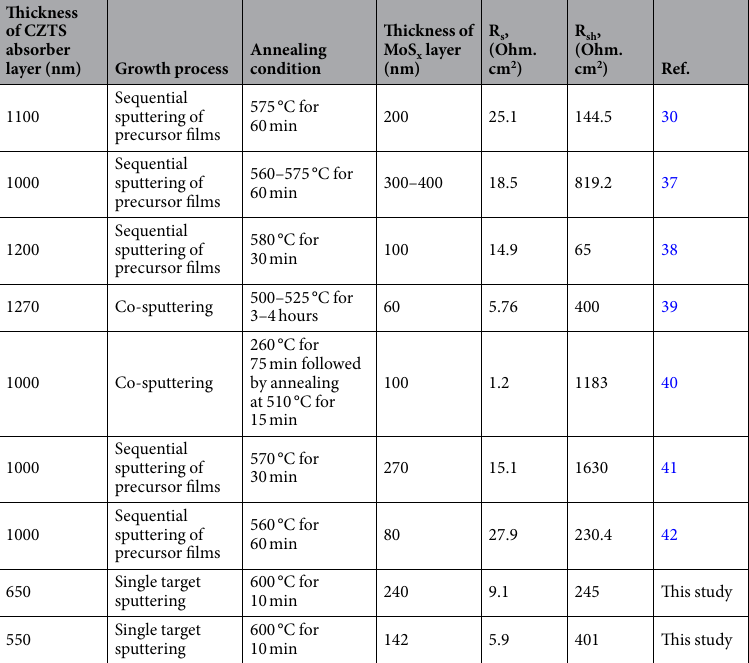
Table 3. Device characteristics of reported CZTS thin film solar cells made by sputtering.